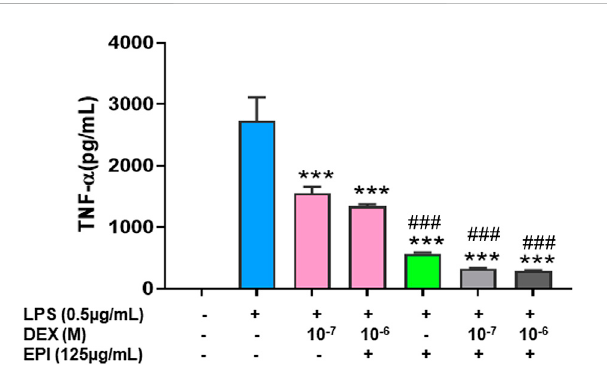
FIGURE 3 Epimedium inhibits CYP3A4 protein expression. HepG2 cells were cultured with Epimedium for 48 h and protein expression was determined using western blotting. (A) . Western Bands (B) . CYP3A4 protein expression. Data represents triplicate experiments and expressed as mean ± SD. * p < .05 vs . control